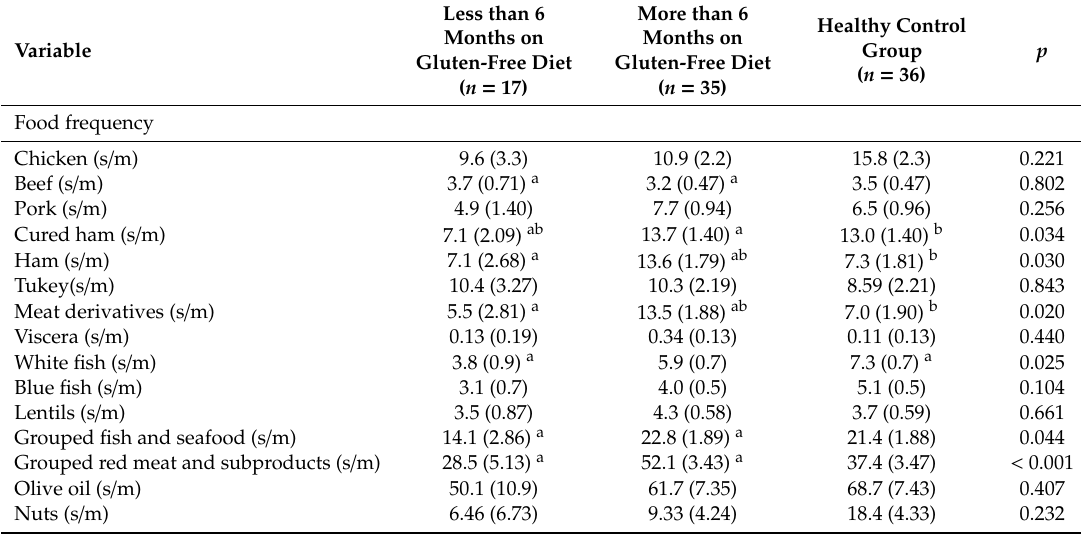
Table 4. Di ff erences between healthy control children, patients with a gluten-free diet in the last 6 months versus less than 6 months on food frequency